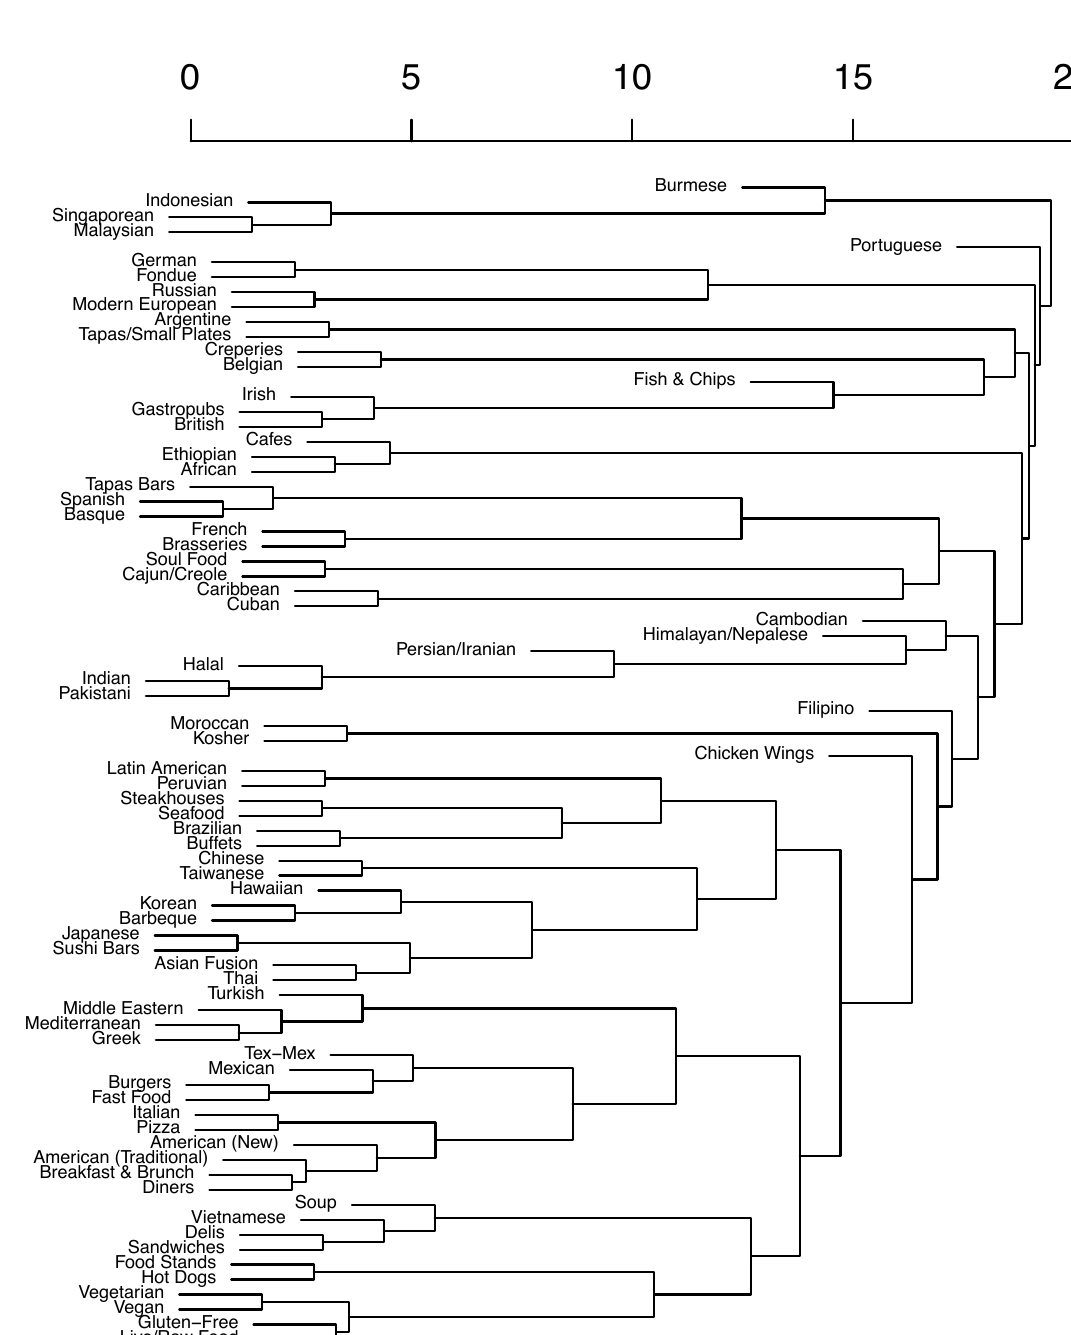
Figure 1: Hierarchical clustering of the food genres (“average distance” method—see text)